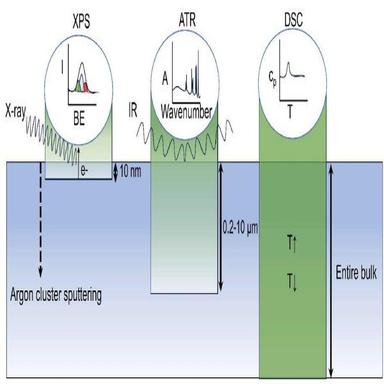
Comparison of the depth of information given by XPS, IR-ATR and DSC.